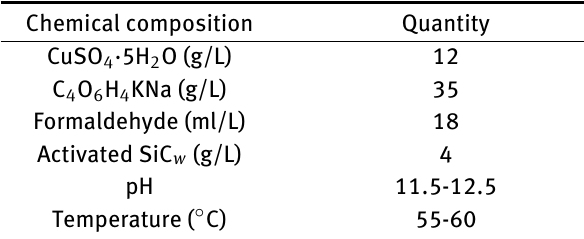
Table 1: Electroless deposition chemical composition Chemical